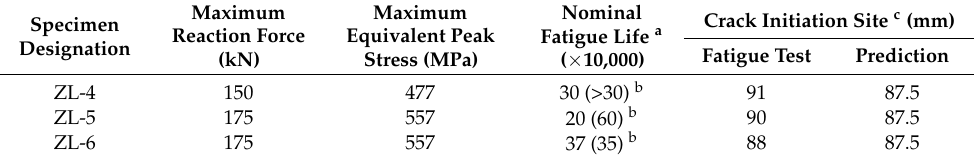
Table 4. Fatigue test results of the variable-section supports with right-angle end plates. Table 4. Cont.